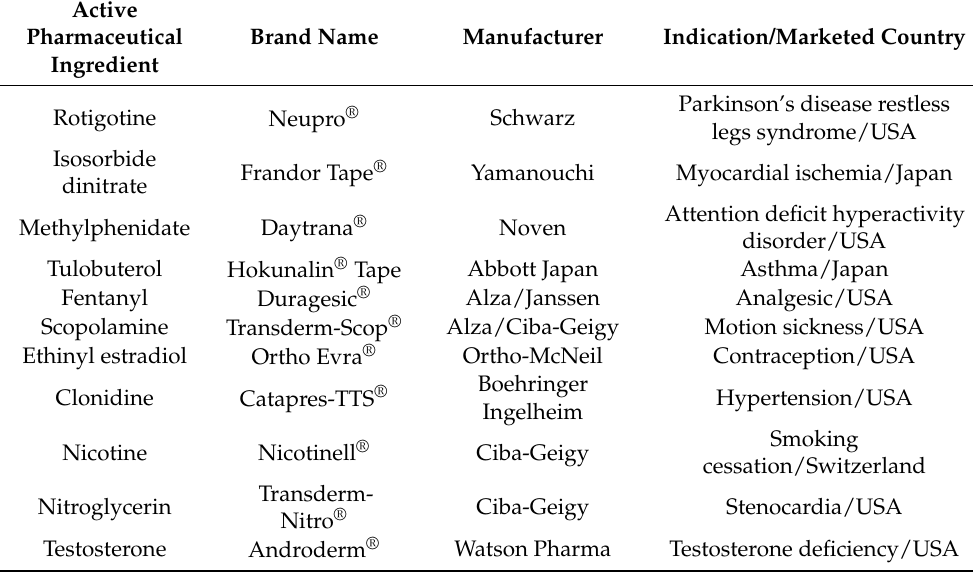
Table 1. A non-exhaustive list of marketed transdermal